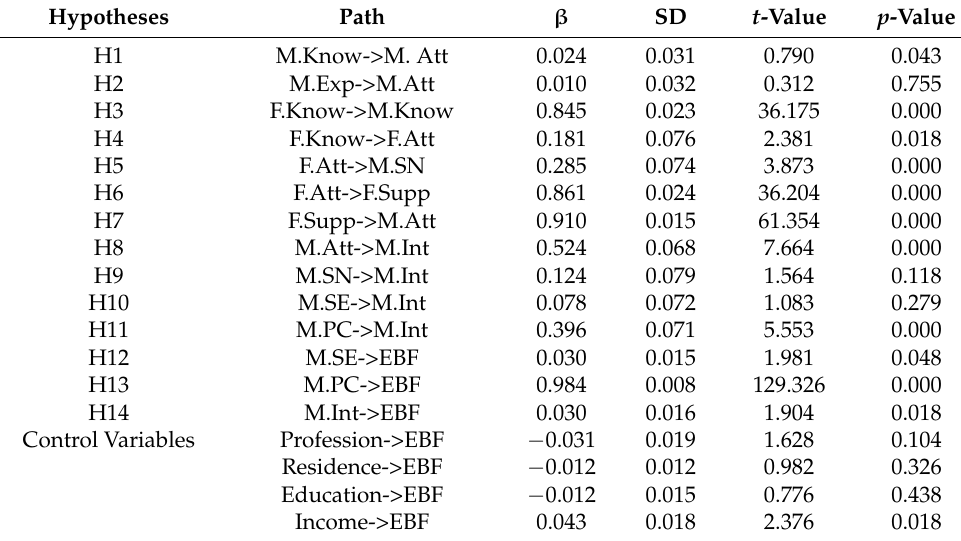
Table A2. Path coefficients of SEM (using vaginal delivery